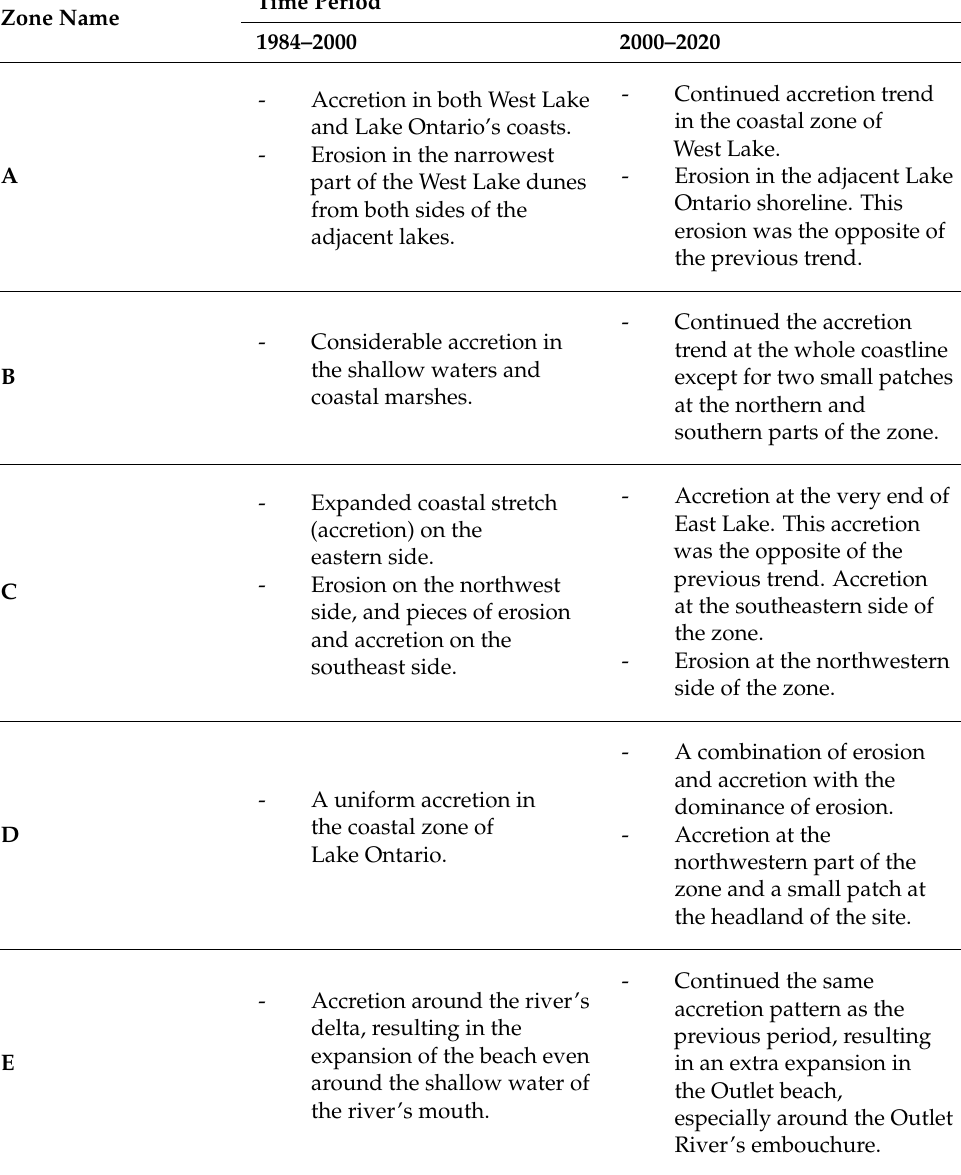
Table 2. Coastal erosion/accretion trends in the study